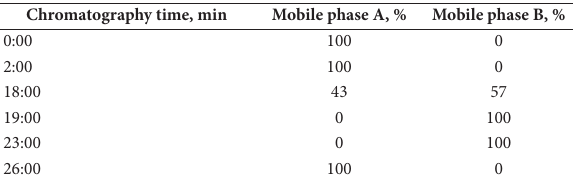
Table 1. Gradient elution